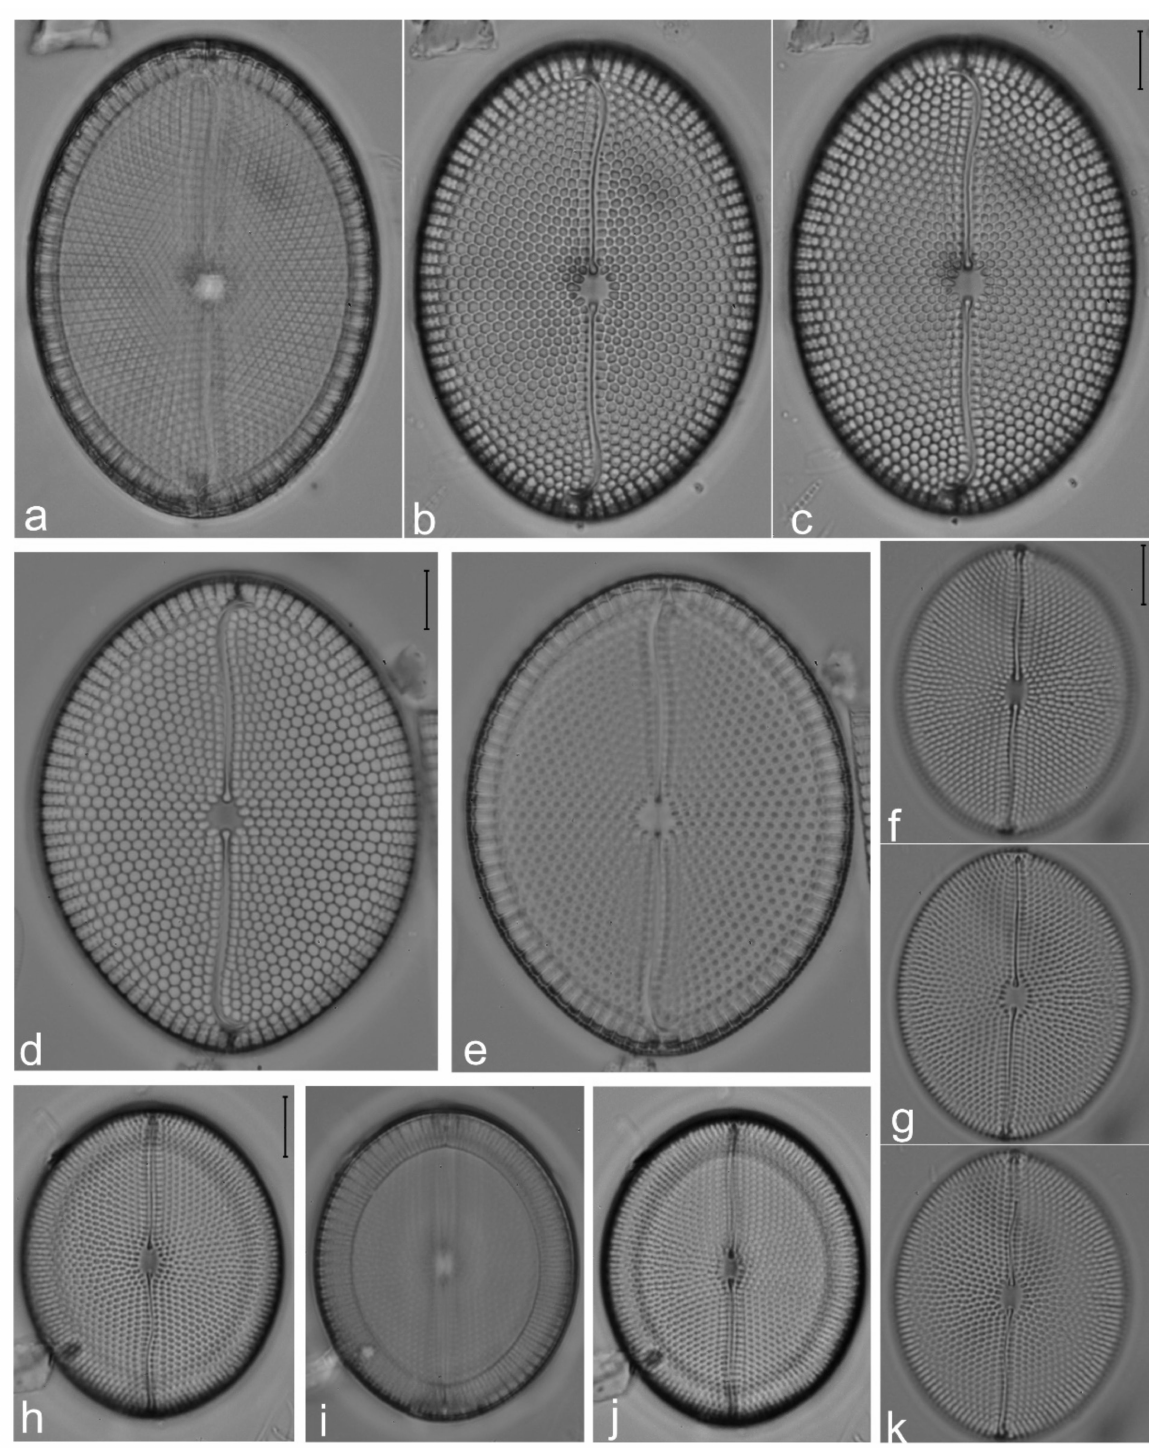
Figure 17. ( a – e ) Mastogloia punctatissima in different focal planes; ( f – k ) M . cocconeiformis valve in different focal planes. Scale bar = 10 µ